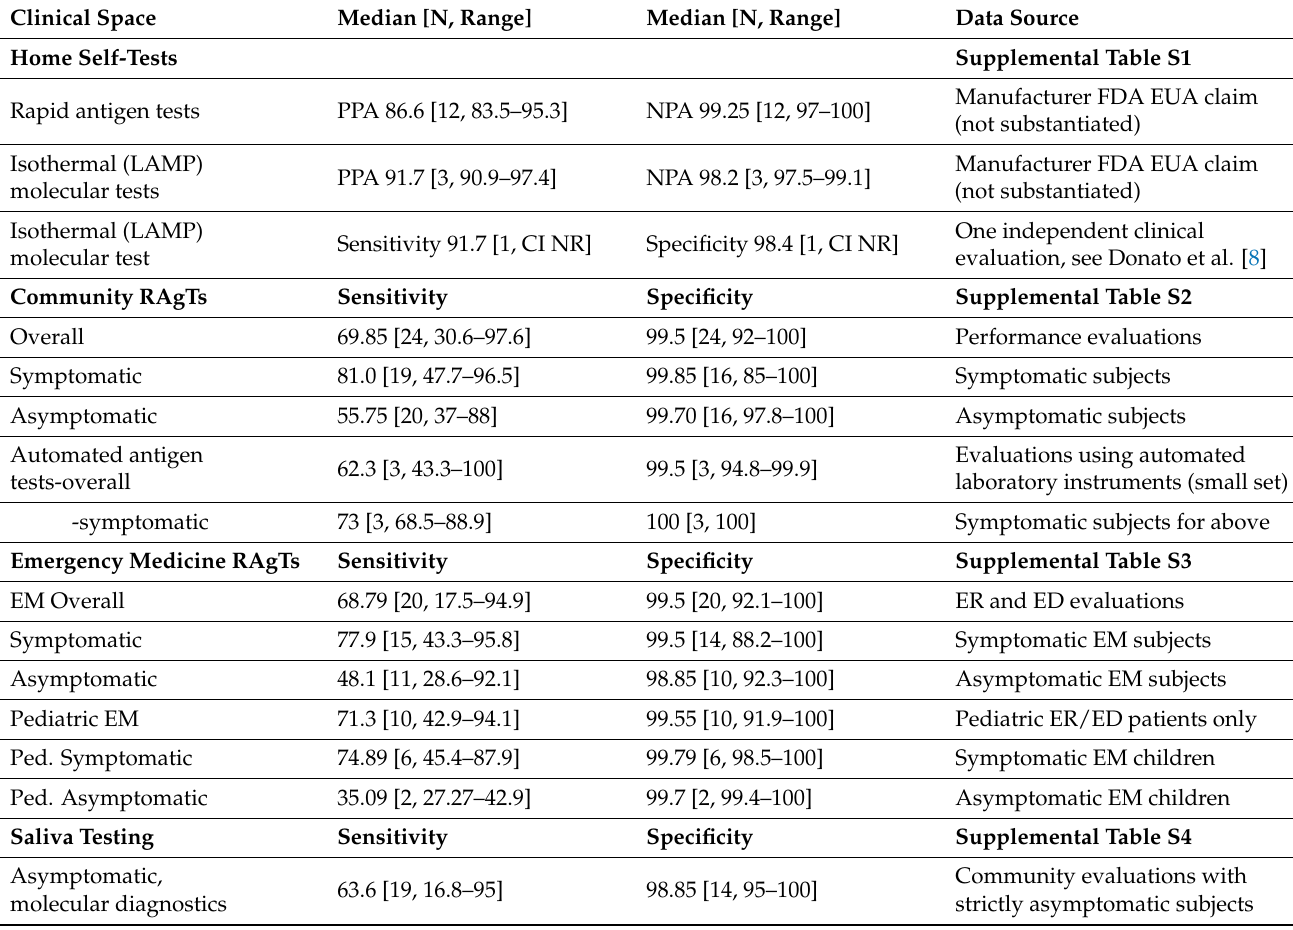
Table 1. Performance Metrics for Home, Community, and Emergency Medicine COVID-19 Testing.